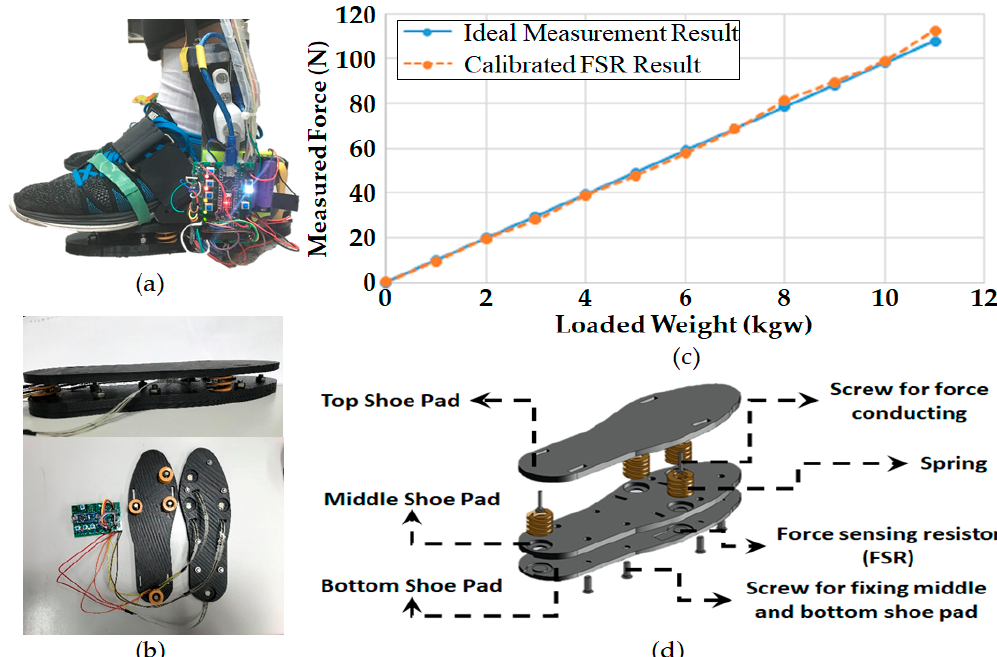
Figure 2. Sensing and communication module on the foot and the calibration result of one FSR; ( a ) Side view of the module installed on the foot; ( b ) photos of the module; ( c ) FSR calibration result. The blue solid line and the orange dashed line represent the ideal and calibrated results, respectively; and ( d ) explosion drawing of the module.